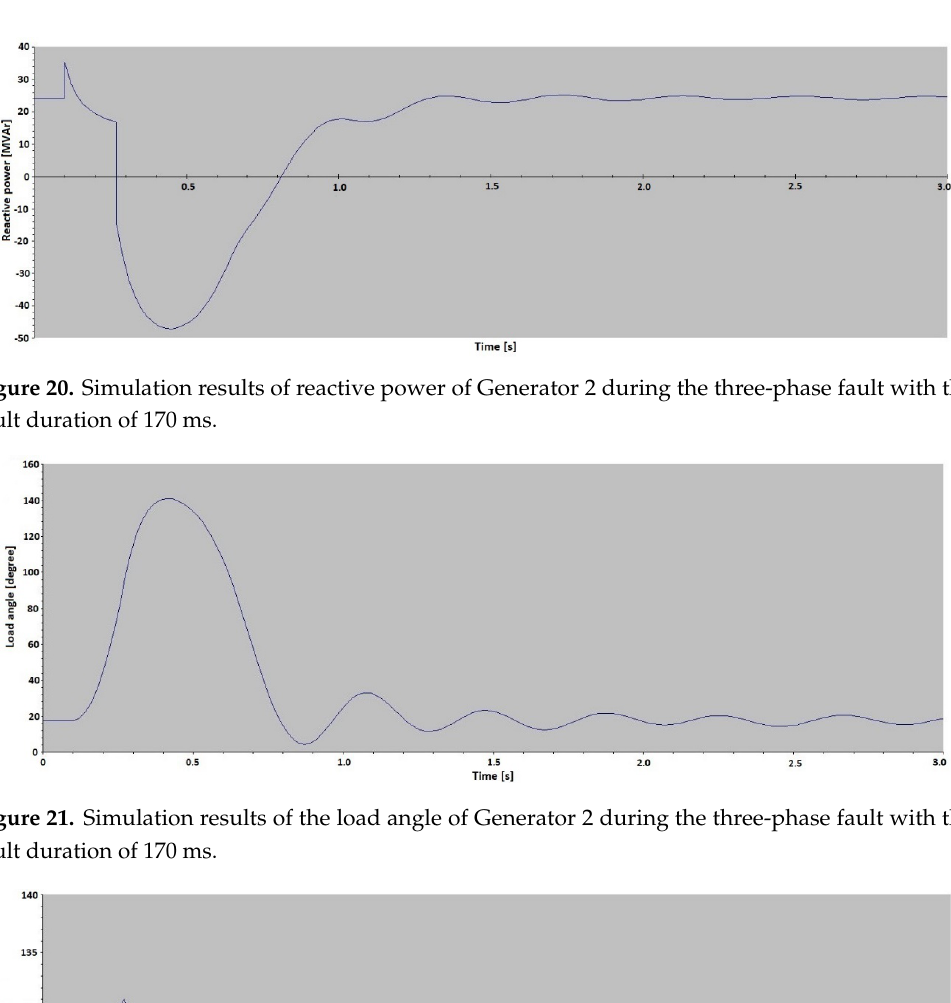
Figure 19. Simulation results of active power of Generator 2 during the three-phase fault with the fault duration of 170 ms.